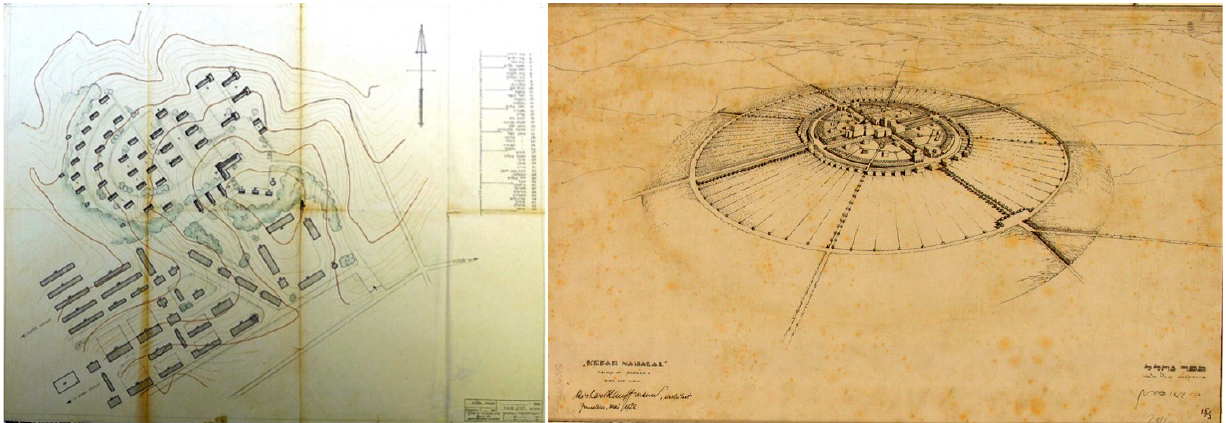
Figure 2. Left: Kibbutz Shoval. Right: Moshav Nahalal. Sources: Sharon (1946) and Kauffmann